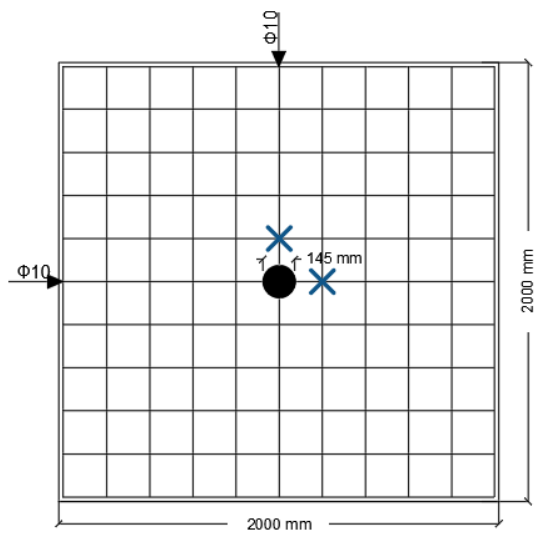
Figure 3. Position of strain gauges on the bottom reinforcement mesh.